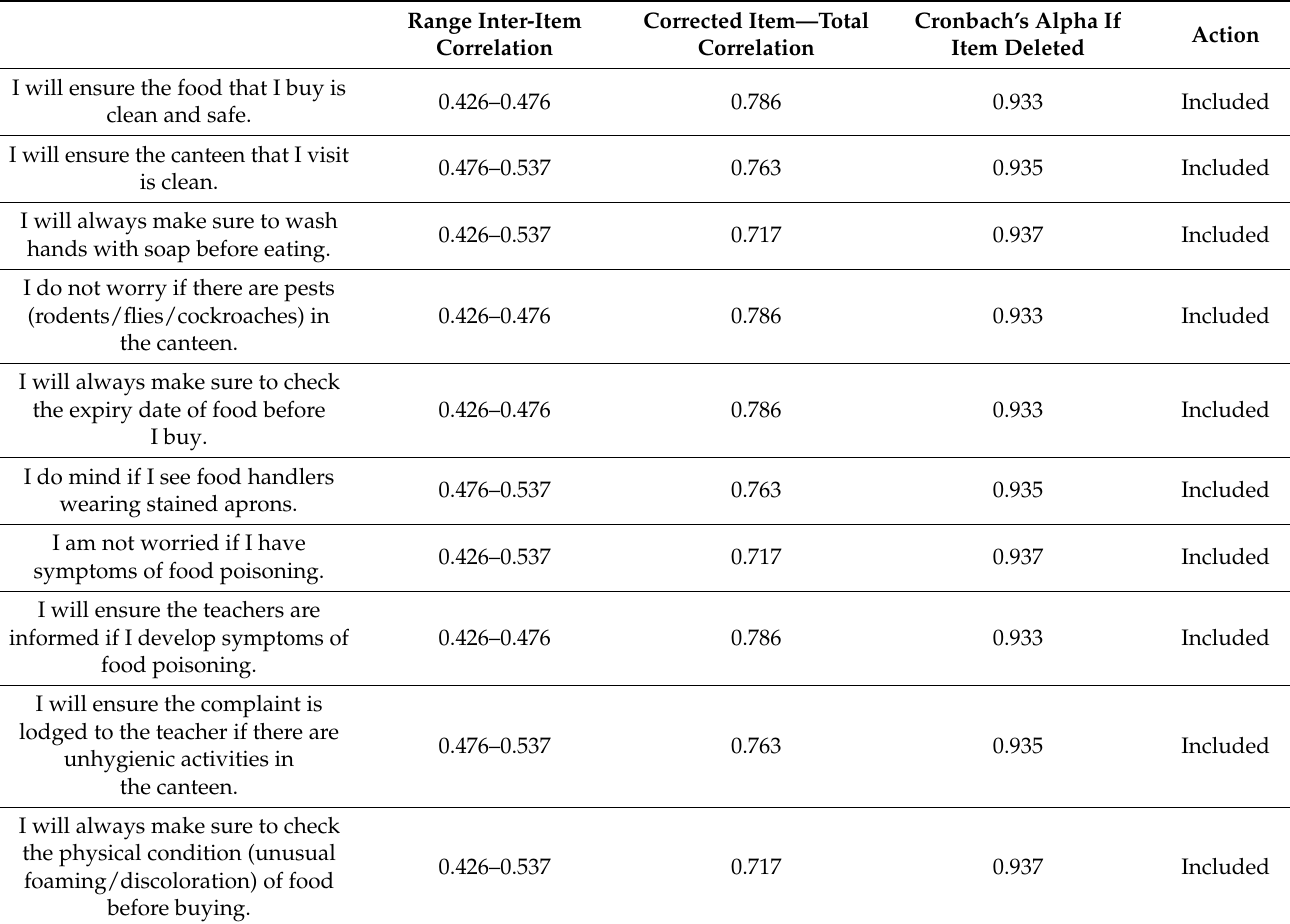
Table 3. Item analysis of attitude toward prevention of food poisoning (N = 30).